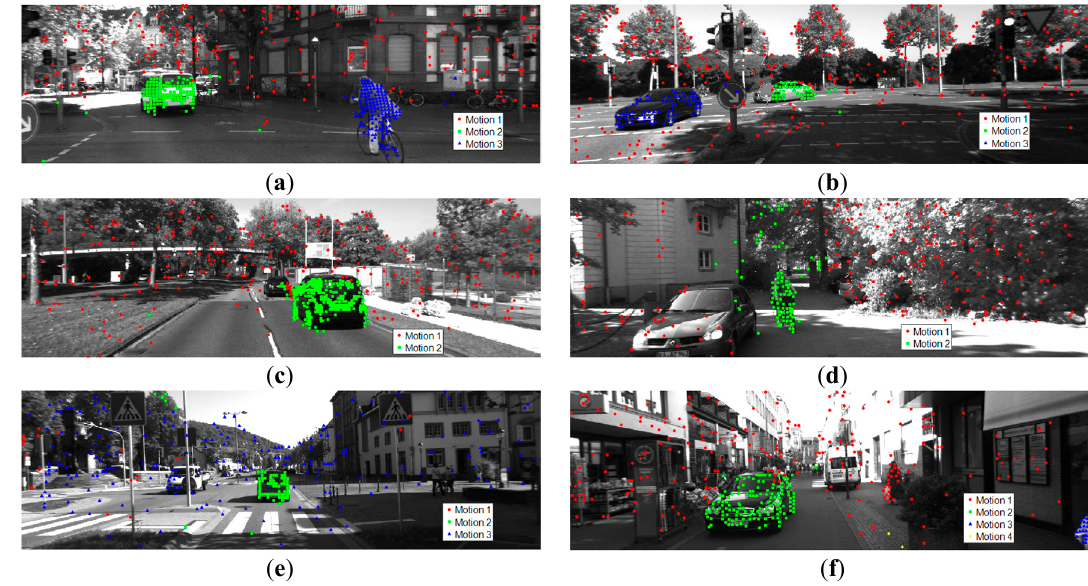
Figure 6. Sample results in video sequences of the KT3DMoSeg dataset with the proposed method, with the different motions labeled with points of different colors and shapes. ( a ) Seq005_Clip01, ( b ) Seq009_Clip03, ( c ) Seq013_Clip02, ( d ) Seq113_Clip01, ( e ) Seq005_Clip01, ( f ) Seq071_Clip01.